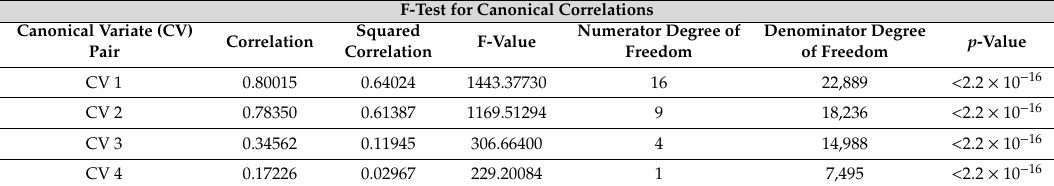
Table 2. The F-test results for canonical correlations of each canonical variate pair. F-Test for Canonical Correlations Canonical Variate (CV)